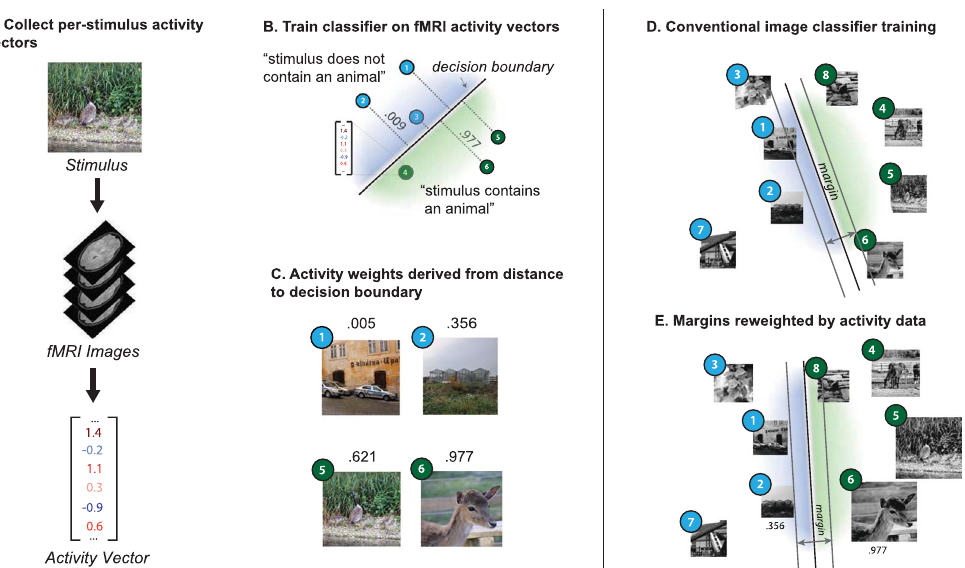
Figure 1. Experimental workflow for biologically-informed machine learning using fMRI data. ( A ) fMRI was used to record BOLD voxel responses of one subject viewing 1,386 color images of natural scenes, providing labelled voxels in several conventional, functional ROIs (i.e., EBA, FFA, LO, OFA, PPA, RSC, and TOS) 41 . ( B ) For a given binary object category classification task (e.g., whether a stimulus contains an animal), the visual stimuli and voxel activity data were split into training and test sets (not shown). An SVM classifier was trained and tested on voxel activity alone. ( C ) To generate activity weights, classification scores, which roughly correspond to the distance of a sample from the decision boundary in ( B ), were transformed into a probability value via a logistic function 48 . ( D,E ) The effects of using activity weights were assessed by training and testing two classification models on image features of the visual stimuli: ( D ) One SVM classifier used a loss function (i.e., hinge loss [HL]) that equally weights the misclassification of all samples as a function of distance from the SVM’s own decision boundary. ( E ) Another SVM classifier used a modified loss function (i.e., activity weighted loss [AWL]) that penalizes more aggressively the misclassification of samples with large activity weights. In training, these classifiers in ( D ) and ( E ) only had access to activity weights generated in ( C ); in testing, the classifiers used no neural data and made predictions based on image features alone. (Images used in this figure are from 69 and are freely available via